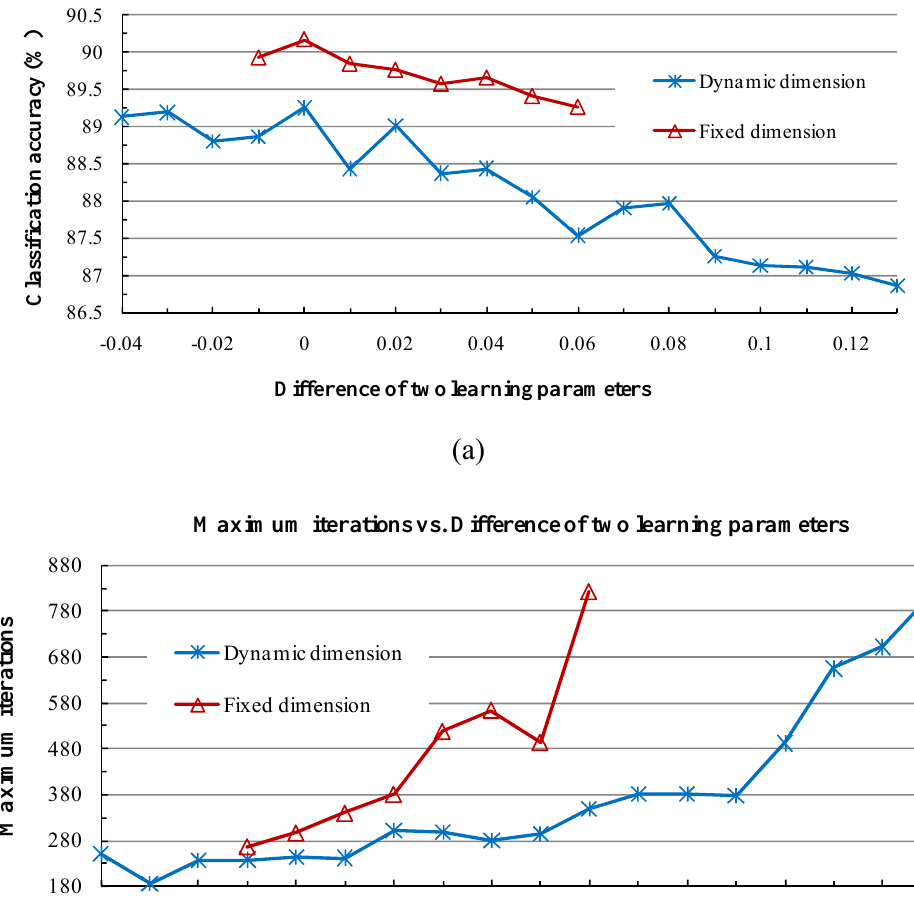
Figure 3. Classification accuracy and maximum iterations vs. the difference between  and  . (a) and (b) show the classification accuracy and maximum training iterations, respectively, with various learning parameters by the dynamic subspace method in which  was fixed at 0.3 while  varied from 0.17 to 0.34; and with various learning parameters by the fixed subspace method in which  was fixed at 0.39 while  varied from 0.33 to 0.4. Classification accuracy vs. Difference of two learning parameters